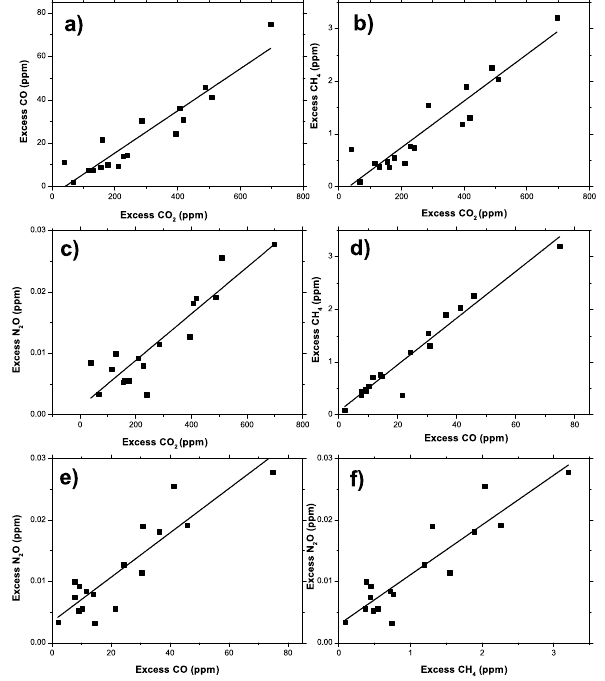
Figure 4. Linear fits of excess mixing ratios for all 18 ex- perimental fires (not corrected for the overall dilution ratio) using either CO 2 , CO or CH 4 as a reference gas: (a) CO plotted against CO 2 ( R 2 = 0.872, CO =− 3.99 + 0.097CO 2 ); (b) CH 4 plotted against CO 2 ( R 2 = 0.871, CH 4 =− 0.14 2 = 0.811, + 0.0044CO 2 ); (c) N 2 O plotted against CO 2 ( R N 2 O = 0.0012 + 3.79 × 10 − 5 CO 2 ); (d) CH 4 plotted against CO ( R 2 = 0.942, CH 4 =− 0.066 + 0.044CO); (e) N 2 O plotted against CO ( R 2 = 0.788, N 2 O = 0.0035 + 3.61 × 10 − 4 CO); (f) N 2 O plotted against CH 4 ( R 2 = 0.822, N 2 O = 0.0030 + 0.0081CH 4 ).